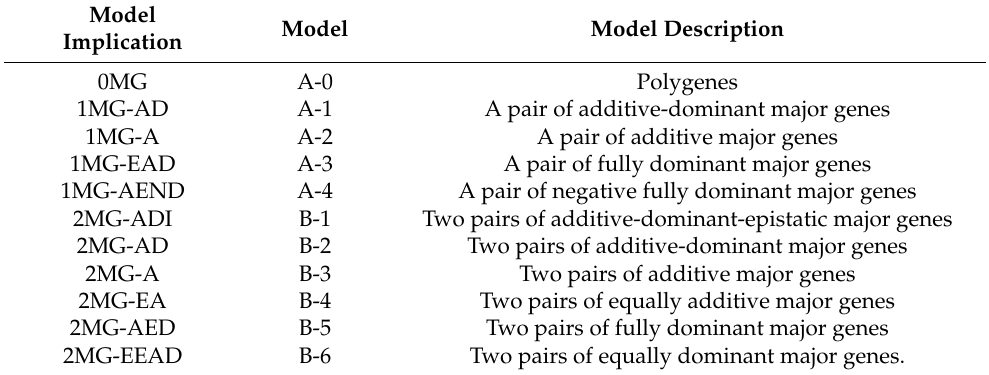
Table 1. Descriptions of the genetic